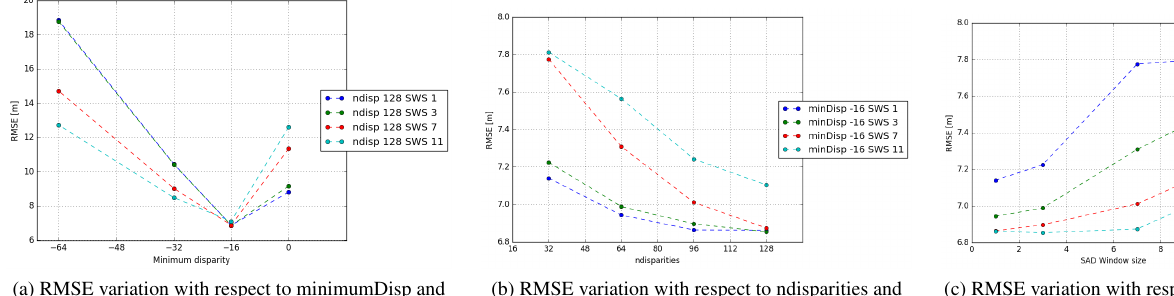
Figure 5: SGBM parameters effect on DSM